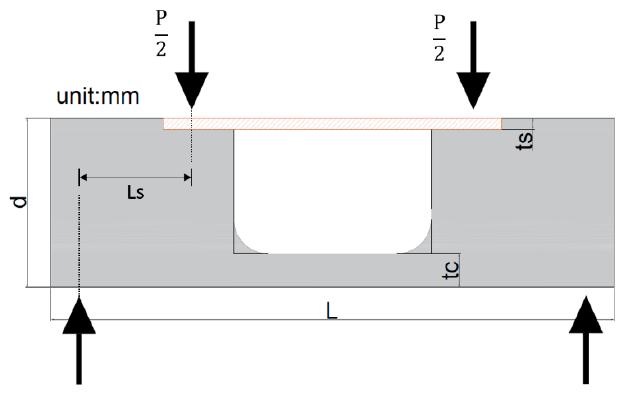
Figure 11. Geometry of strut-and-tie beam (width equals to b).